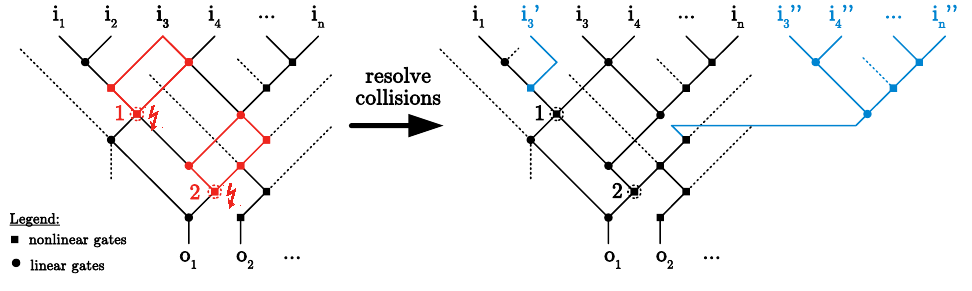
Figure 4: Example for collisions directly caused by inputs (1) and collisions caused by gates (2), collisions (left) and resolved collisions